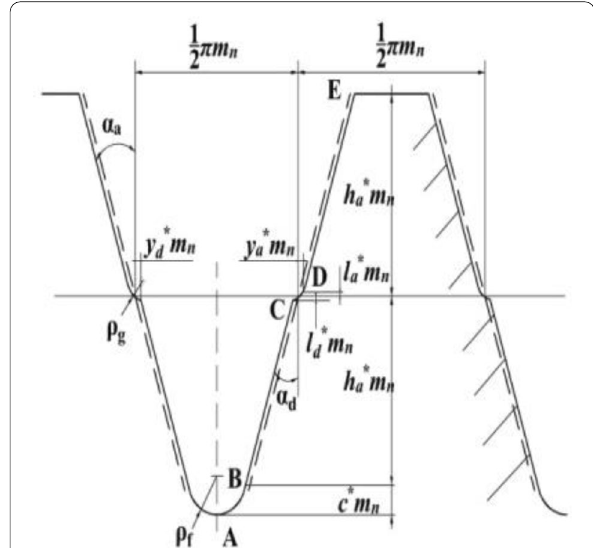
Figure 2 Basic tooth profile of double involute gears